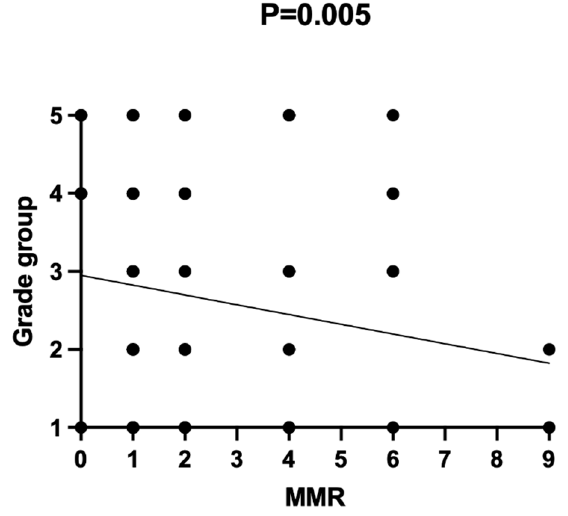
Figure 7. Association between MMR expression and grade group via Pearson’s chi-squared test ( χ 2). Pearson’s χ 2 = 0.0088; p = 0.005.